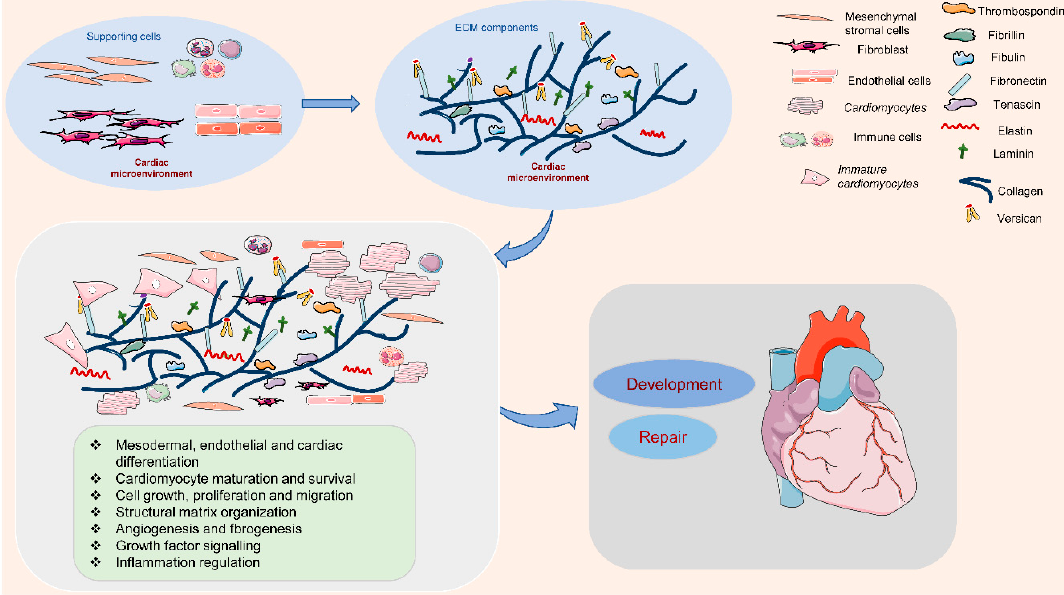
Figure 1. Extracellular matrix (ECM) components and their role in the cardiac microenvironment during heart development and repair. In the cardiac microenvironment, supporting cells, including mesenchymal stromal cells, fibroblasts, endothelial cells, and immune cells, produce the main ECM proteins. These ECM components promote cardiomyocyte differentiation, maturation, and survival, and the interaction between cardiomyocytes and supporting cells, contributing to heart development and repair.